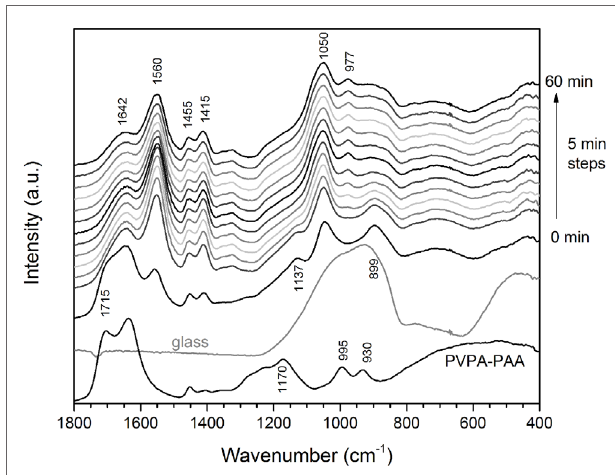
FigUre 3 | changes in FTir spectra with setting time for cements made using glass sr10 . Spectra of PVPA–PAA solution and the untreated glass are given for